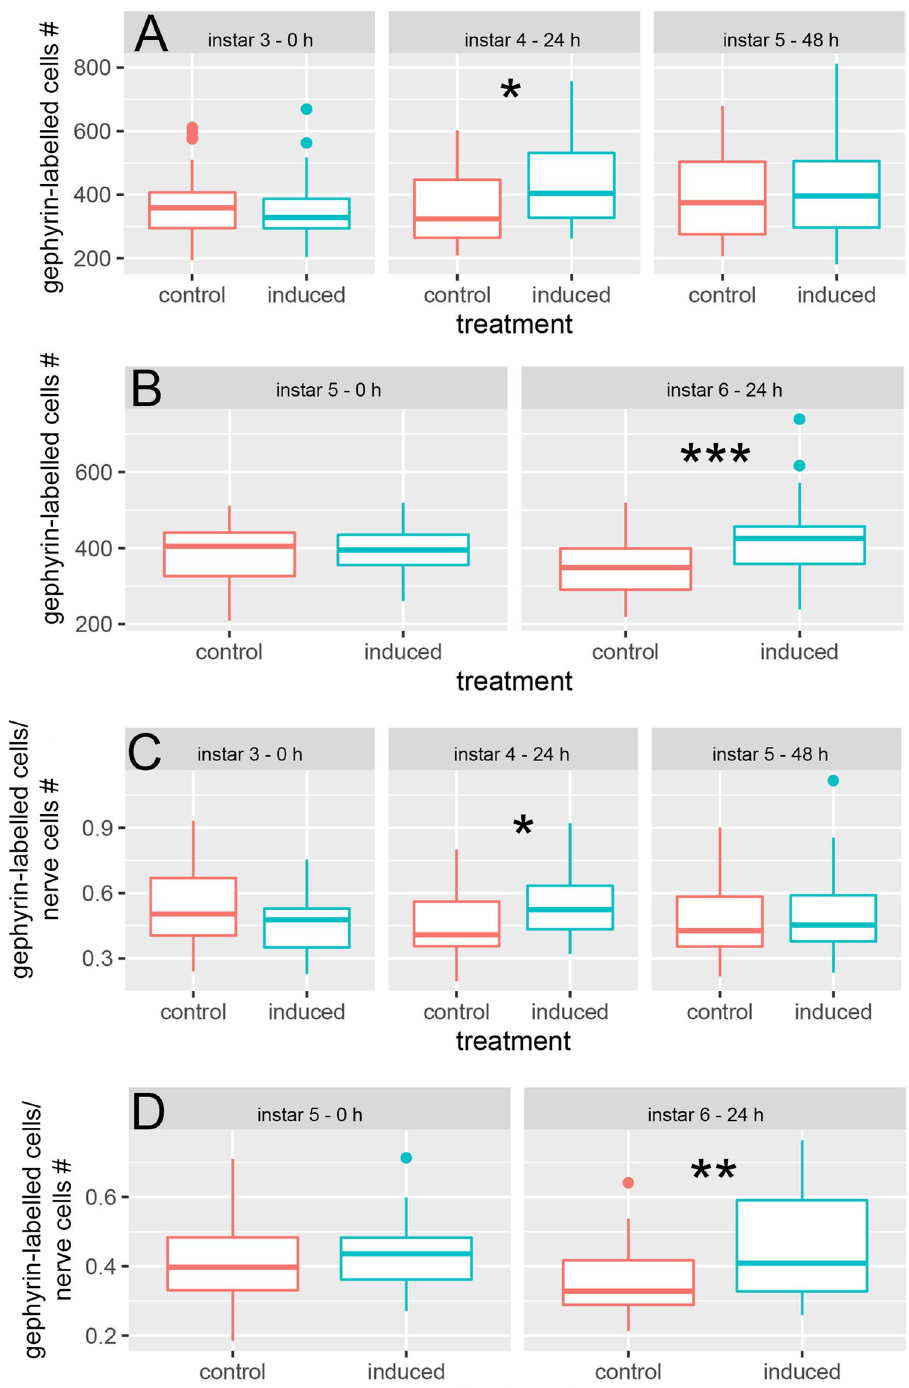
Figure 5. Functional plasticity underlying morphological defense expression. ( A ) When exposed to predators from the 3rd instar onwards, the number of gephyrin-labelled cells is significantly increased after 24 h predator-exposure compared to the control ( P = 0.013; t = − 2.56; df = 57) and to the 3rd instar (ANOVA: F (2;97) = 3.12 P = 0.049 Tukey: P = 0.039). ( B ) When exposed to predators from the 5 th instar onwards, the number of gephyrin-labelled cells is significantly increased after 24 h predator exposure compared to the control ( P ≤ 0.001; t = − 3.63; df = 44). ( C ) The number of gephyrin-labelled cells per nerve cells is significantly increased compared to the control after 24 h predator exposure, when the animals were exposed to predators from the 3rd instar onwards ( P = 0.011; t = − 2.65; df = 57). ( D ) When exposed to predators from the 5th instar, the ratio of gephyrin-labelled cells/nerve cells is significantly increased compared to the control after 24 h predator exposure ( P ≤ 0.001; t = − 3.41; df = 44). ( A , C) Alpha corrected levels of significance: * P ≤ 0.017. (B , D) Alpha corrected levels of significance: ** P ≤ 0.005; *** P ≤ 0.0005. Boxplots show median (middle line), 25th to 75th percentiles (box) and whiskers show highest and lowest value within 1.5× the interquartile range (1.5× below the 25th percentile and 1.5× above the 75th percentile), respectively. Dots indicate outliers > 1.5× the interquartile